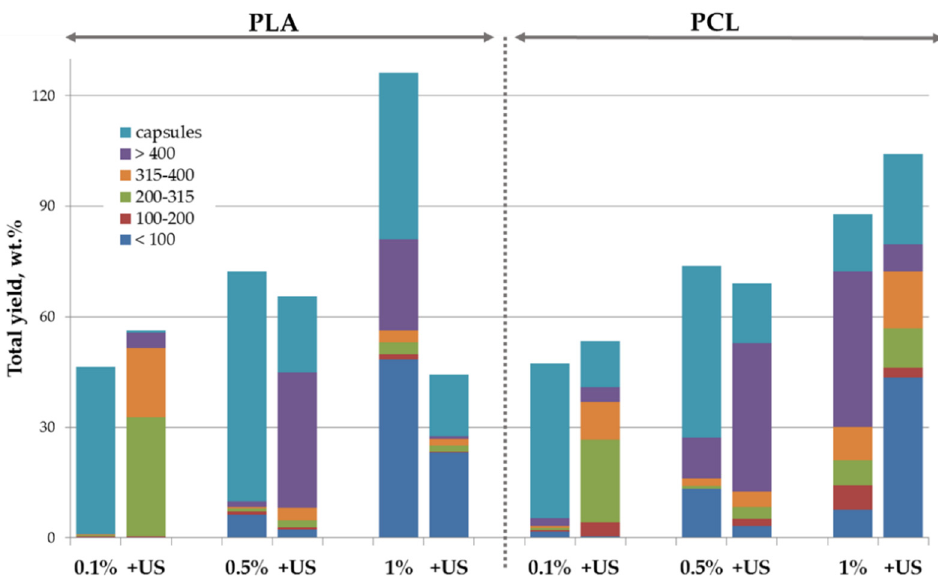
Figure 3. Effect of nature of polymer dissolved within oil phase (PLA or PCL), composition, and pre-treatment conditions of aqueous phase consisted of water dispersion of nHA on the processing yield and size distribution of the hybrid microparticles. Concentration (wt.%) of nHA in aqueous phase is indicated below; US—additional ultrasound treatment of the aqueous phase.